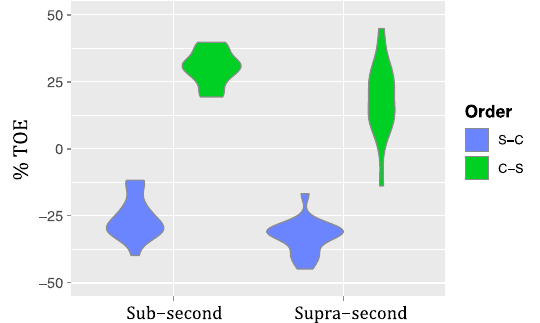
Figure 9. Time-order-errors. Violin plots of the magnitude and sign of the time-order-errors for each duration range and presentation order, as percentage of standard duration, across participants of Experiment 3 (logarithmically spaced ratios). The corresponding ANOVA showed a main effect of duration range ( p < 0.001, η 2 = 0.21), a main effect of presentation order ( p < 0.001, η 2 G ( p = 0.056, η 2 G = 0.01).